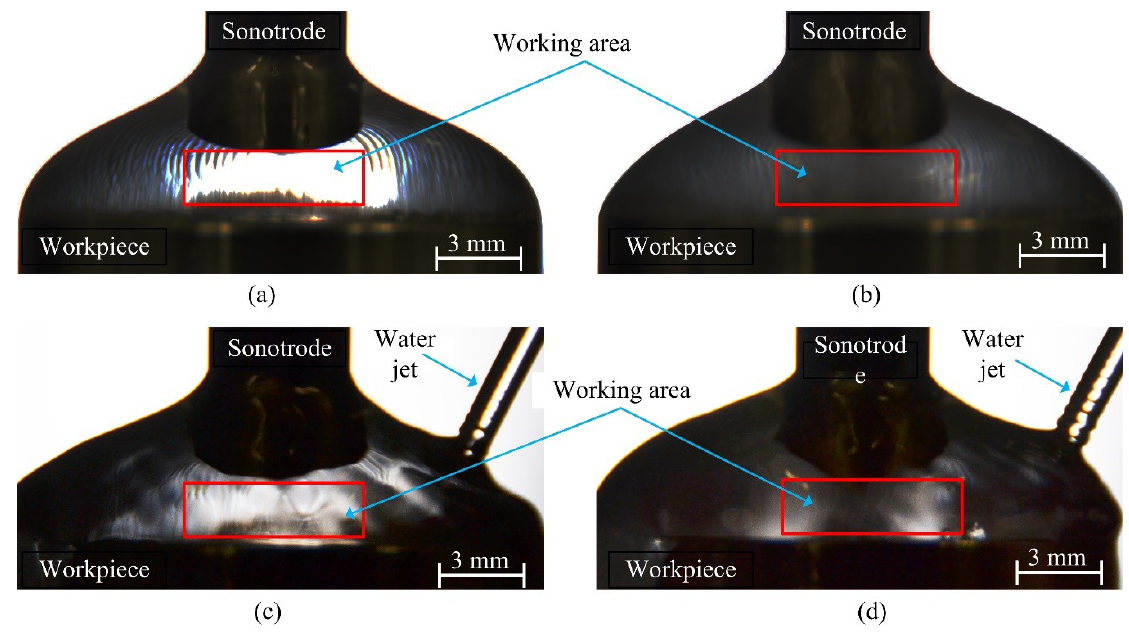
Figure 1. Photos of the small gaps in different experimental conditions: ( a ) No vibration loading without water jet; ( b ) Under vibration loading without water jet; ( c ) No vibration loading with water jet; ( d ) Under vibration loading with water jet.